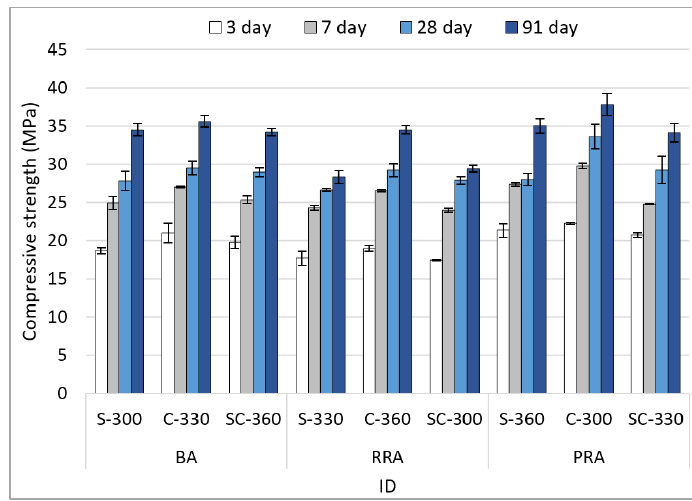
Figure 8. Compressive strength of the concrete.